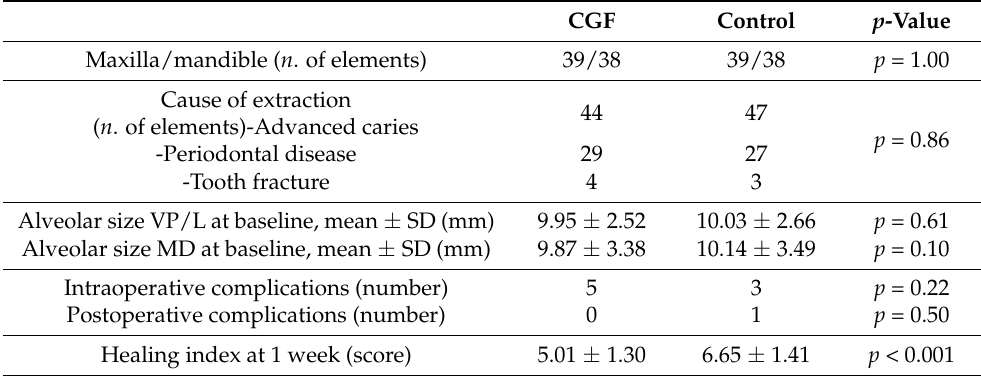
Table 1. Main outcomes and characteristics of the groups. The significance of the between-group difference is shown in the right column.